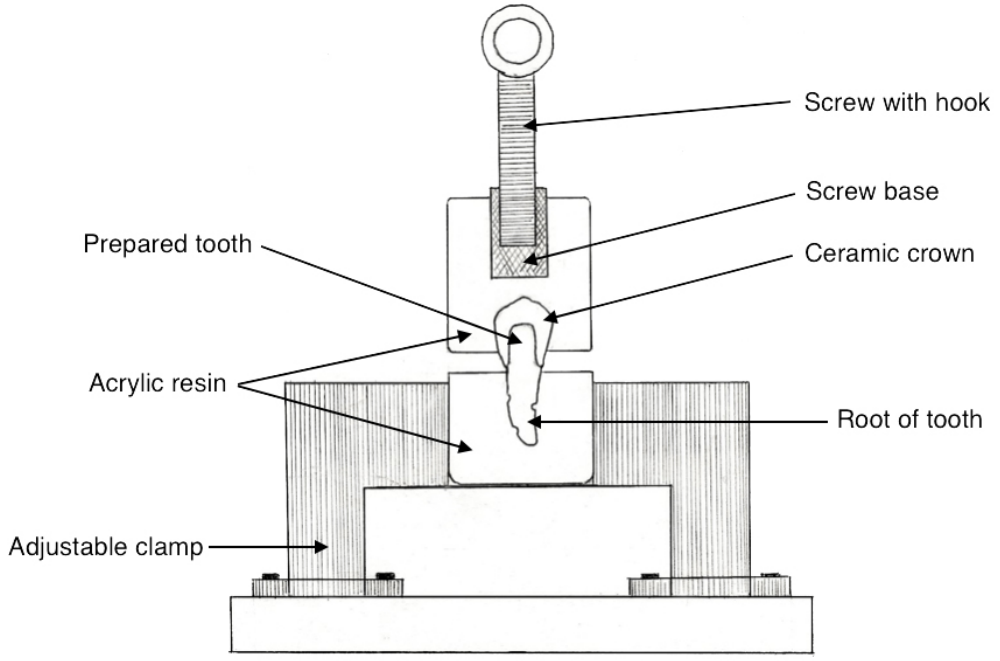
Figure 3. Schematic drawing of the experimental apparatus.